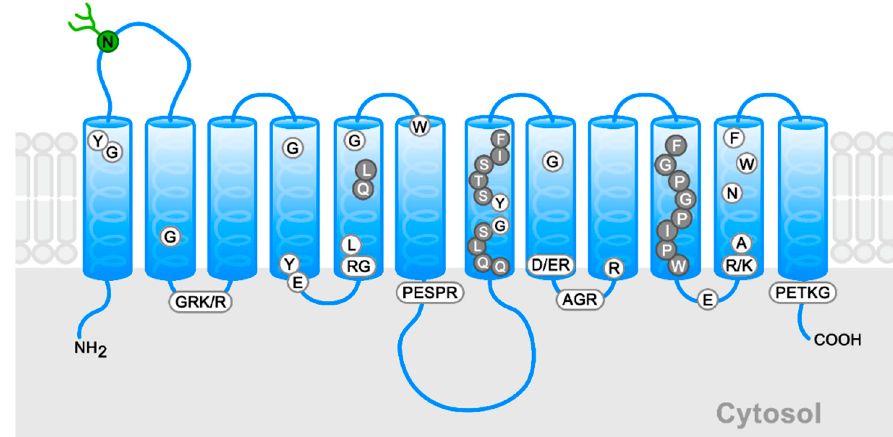
Figure 1. Schematic general model for members of the GLUT family. The conserved signature sequences appear in boxes, conserved residues in white circles, and high conserved residues in gray circles. The N-linked glycosylation site of Class I is indicated in green. The schema is based on the new GLUT1 crystal structure